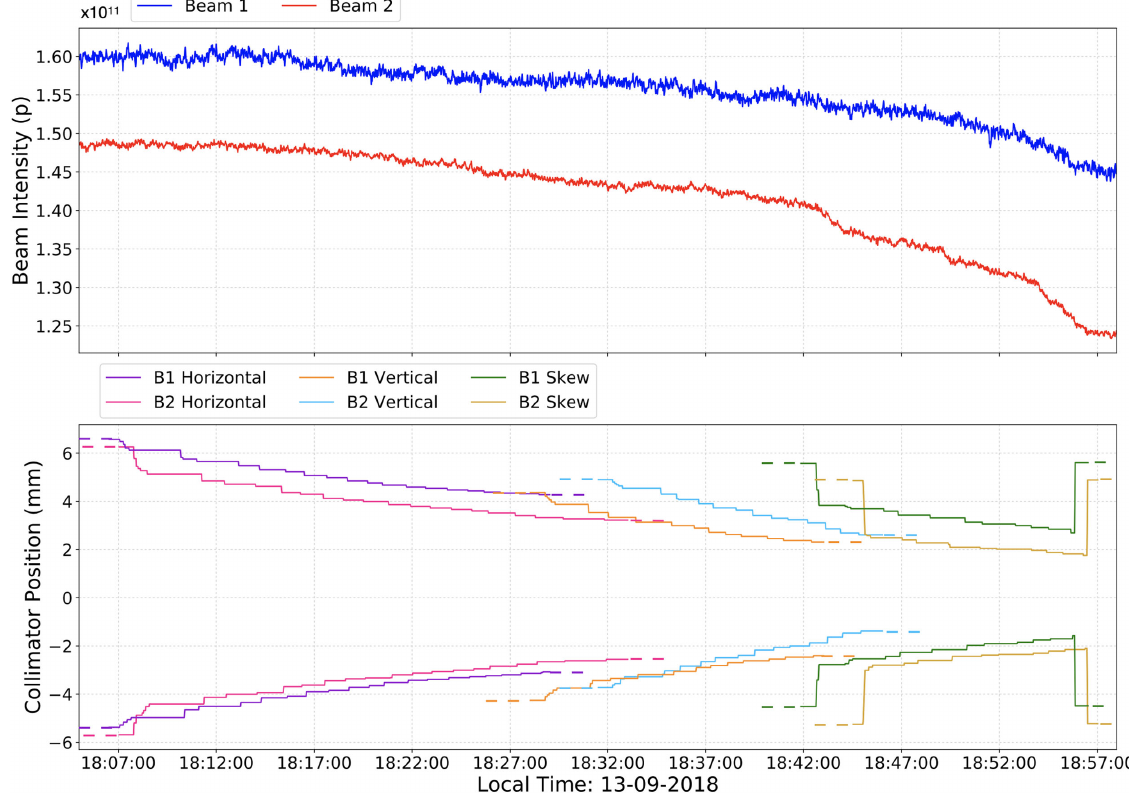
FIG. 12. Parallel alignment of the collimators in the two beams at injection, showing the beam intensities and only the jaw positions of the primary (TCP) collimators for simplicity.